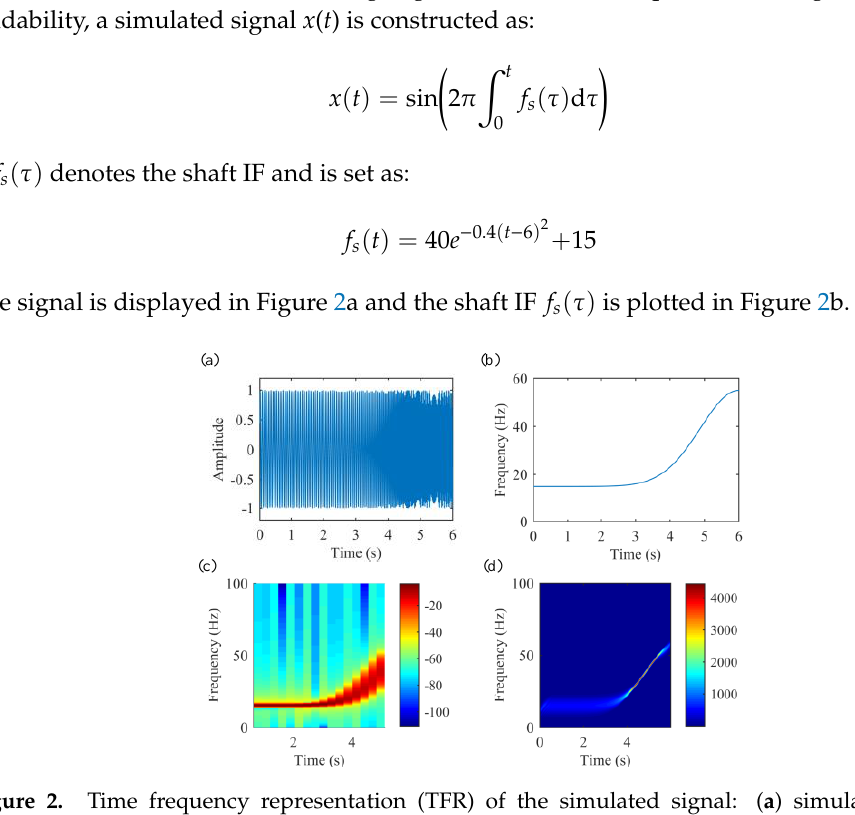
Figure 2. Time frequency representation (TFR) of the simulated signal: ( a ) simulated signal, ( b )Instantaneousfrequency(IF)ofthesimulatedsignal, ( c )shorttimeFouriertransform(STFT)-resulting TFR and ( d ) chirplet transform (CT)-resulting